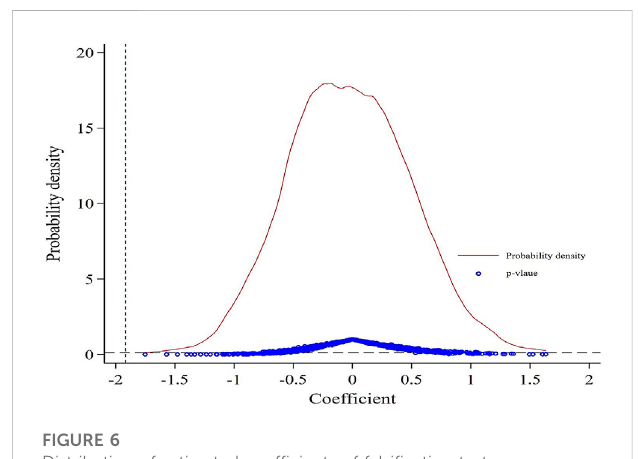
FIGURE 6 Distribution of estimated coef fi cients of falsi fi cation test (1000 simulations).